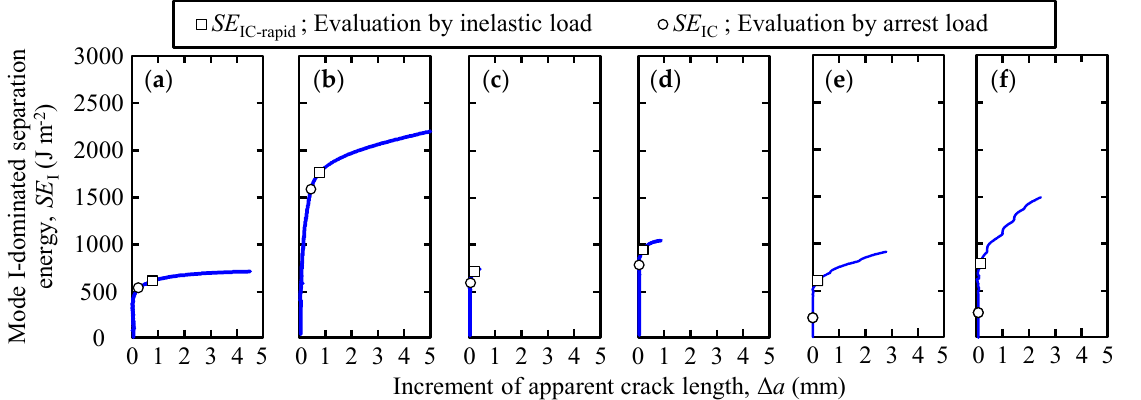
Figure 5. Load–displacement curves of the loading – unloading tests of ( a ) 0.3 mm thickness of Y618H, ( b ) 3.0 mm thickness of Y618H, ( c ) 0.3 mm thickness of Metal Lock, ( d ) 3.0 mm thickness of Metal Lock, ( e ) 0.3 mm thickness of Y611 Black S, and ( f ) 3.0 mm thickness of Y611 Black S.